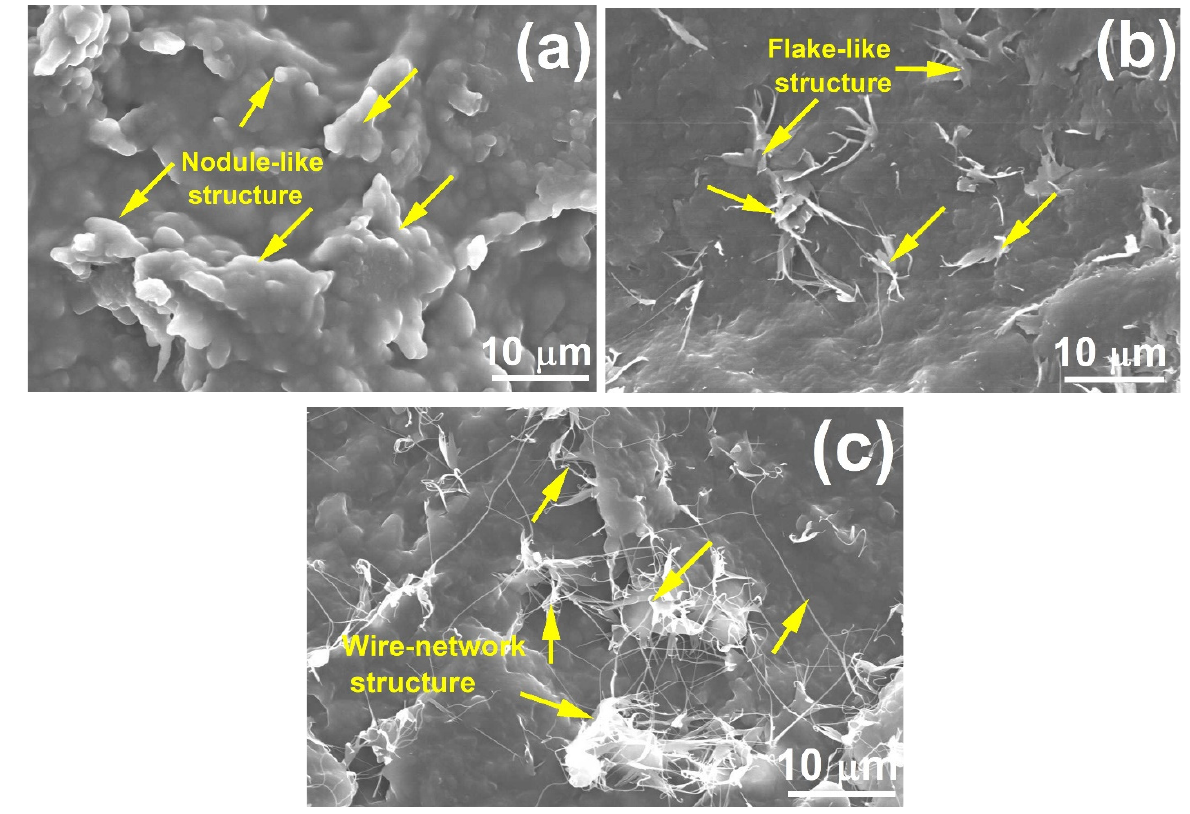
Figure 6. SEM morphology of beeswax-based fuel. ( a ) B1; ( b ) B3; ( c ) B5.